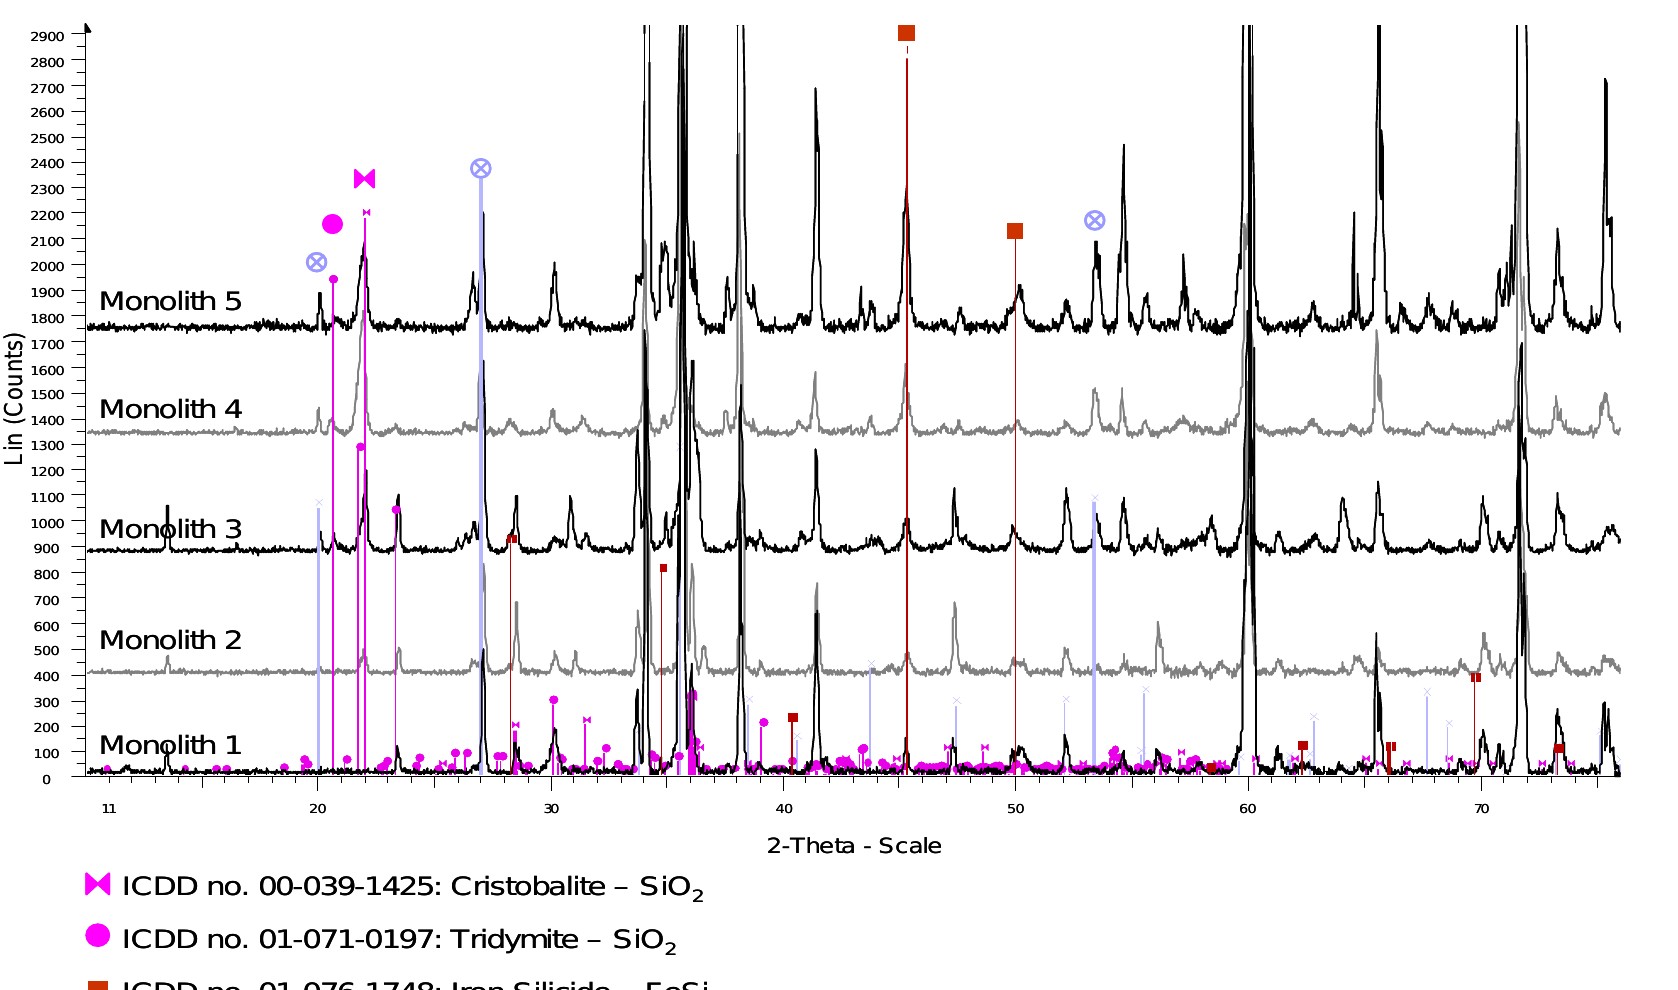
, FeSi and ZrSiO 2 4